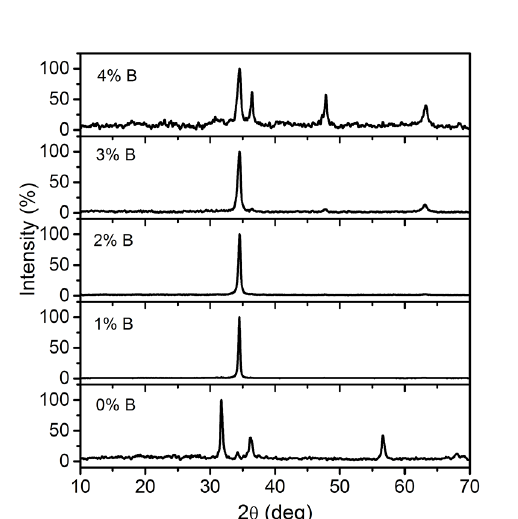
Figure 1. XRD pattern of the spray pyrolysed B-N codoped ZnO thin films with various B